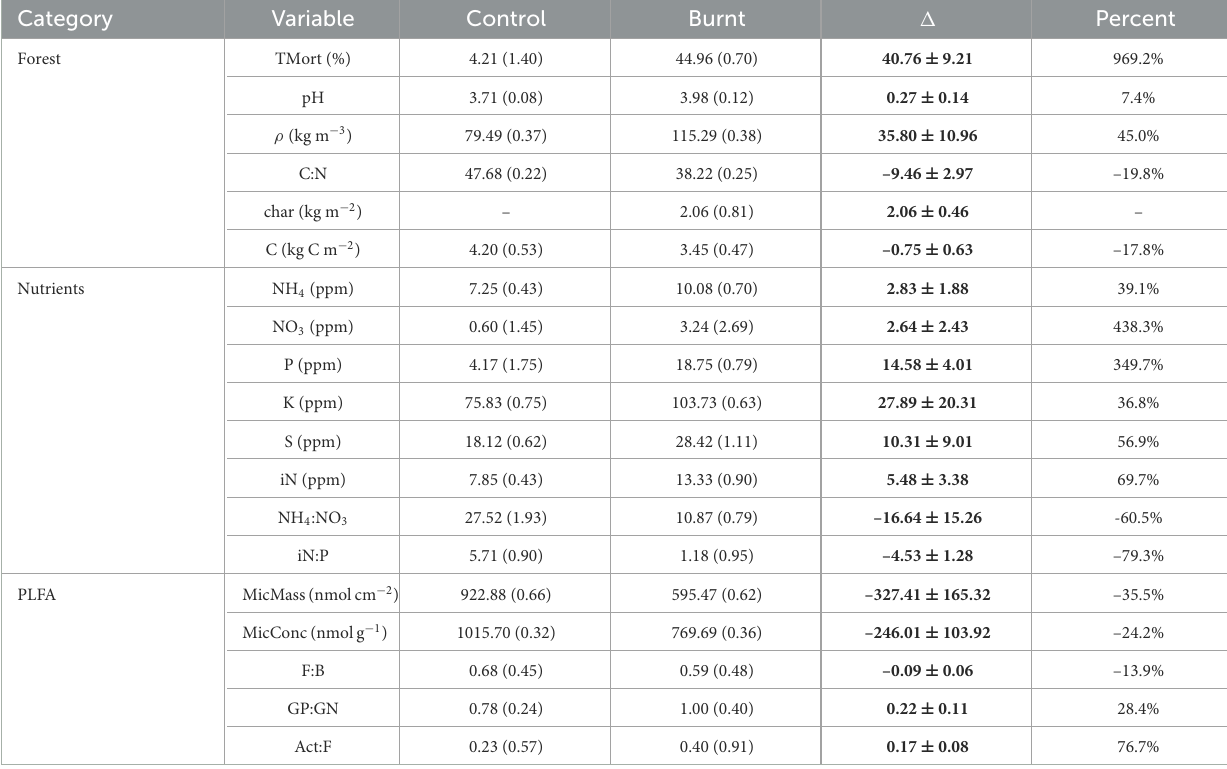
TABLE 2 Mean values for control and burnt plot sampled variables are listed followed by their coefficient of variation in parentheses.